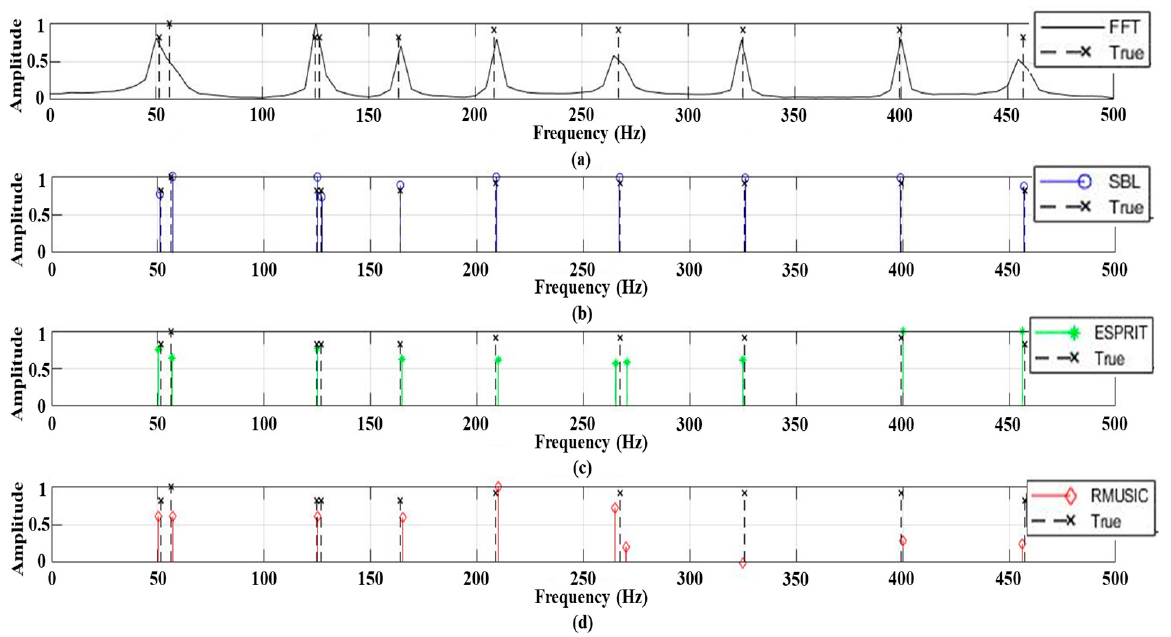
Figure 1. The frequency estimation results using ( a ) fast Fourier transform (FFT); ( b ) sparse Bayesian learning (SBL); ( c ) estimation of signal parameter via rotational invariance techniques (ESPRIT); ( d ) root multiple signal classification (RMUSIC). The signal includes ten frequency components (marked by x) at an SNR of 15 dB.